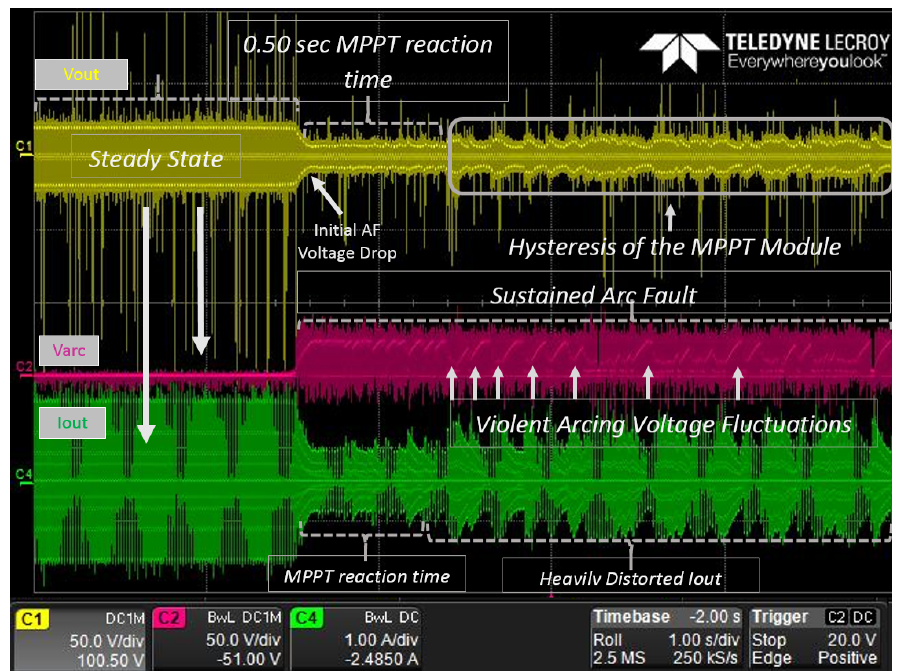
Figure 18. Experimental results of arcing before the MPPT